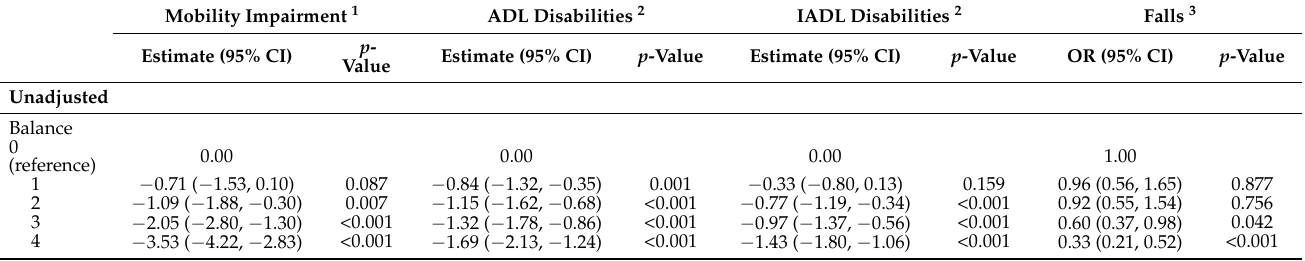
Table 3. Multilevel model results for SPPB domain scores at baseline (balance, repeated chair stands, and gait) on mobility impairment, ADL disabilities, IADL disabilities, and falls over seven waves of follow-up; each exposure was entered in separate